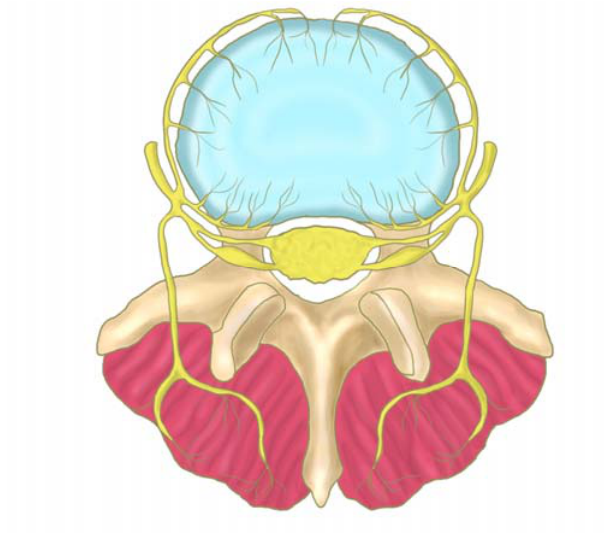
Figure 2. The course of the sinu-vertebral nerve (yellow), which innervates the postero- lateral region of the disc (blue). The nerve exits from the nerve root and enters the vertebral foramen, where it divides into a major ascending and a lesser descending branch (adapted from Raj et al. [34]).